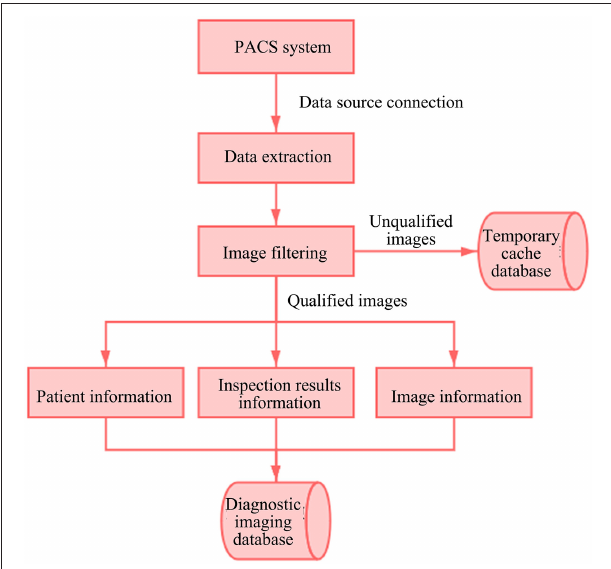
FIGURE 5 | Image data governance process. PACS, Picture Archiving and Communication